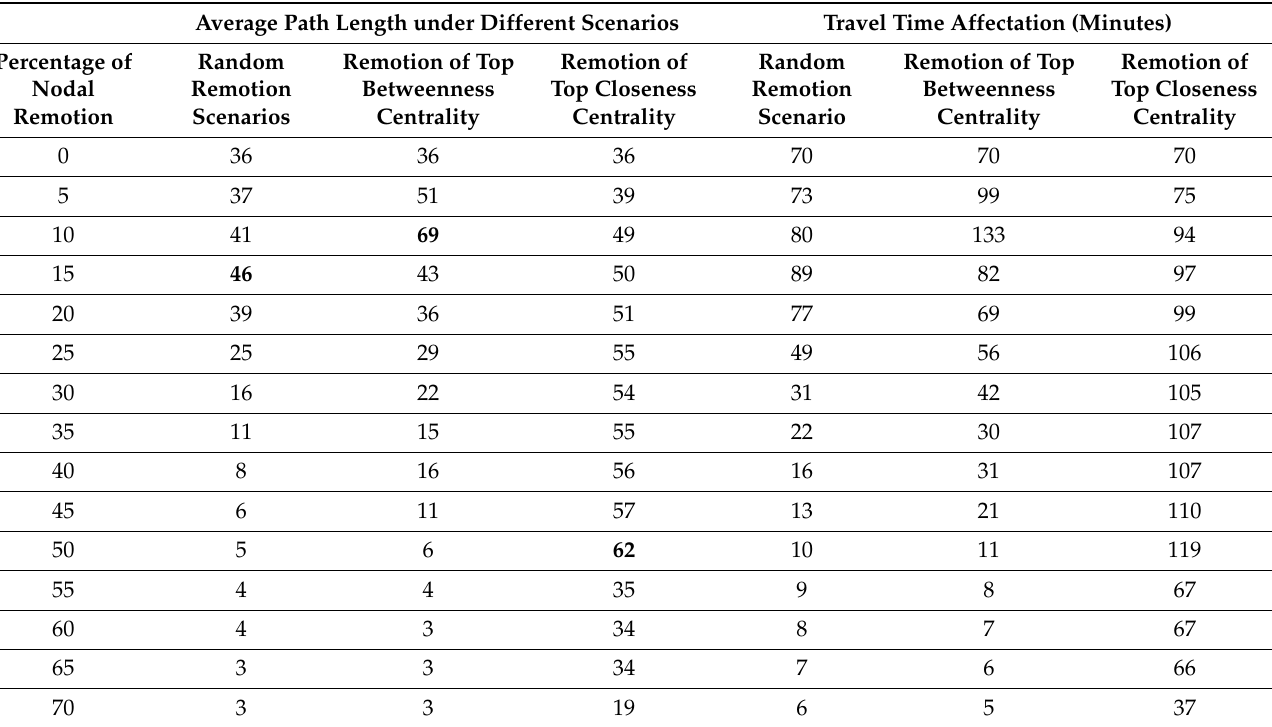
Table 5. Average path length and travel time affectation in different scenario of nodal